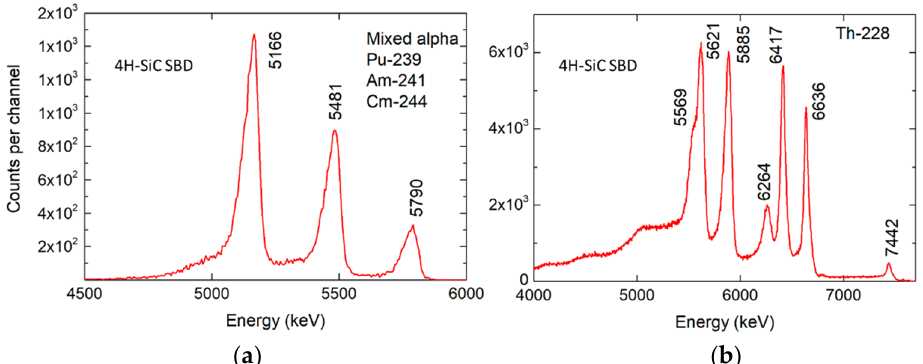
Figure 8. ( a ) Response of the 4H-SiC SBD to mixed alpha particle source (Pu-239, Am-241, Cm-244) and ( b ) response of the same 4H-SiC SBD to Th-228 alpha reference source. Data reproduced from Ref. [9].